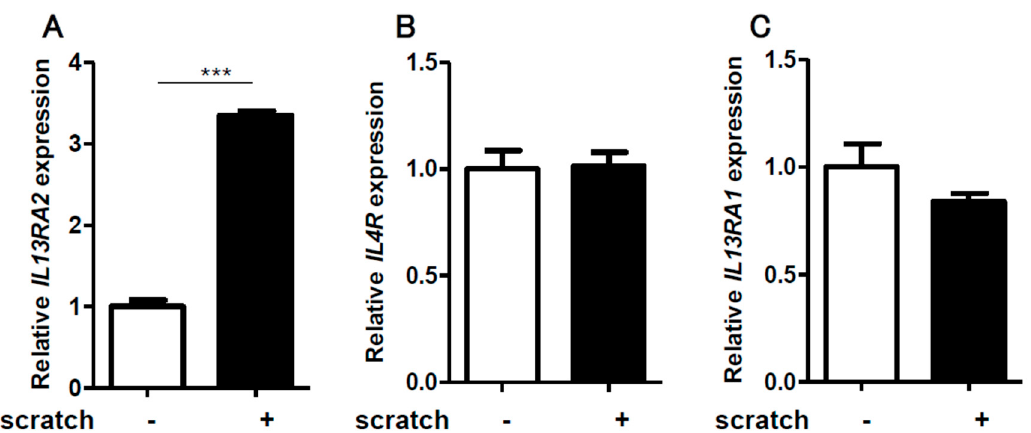
Figure 1. Scratching significantly upregulates the expression of IL13RA2 in NHEK cells. A confluent keratinocyte culture was scratched with 14 lines, and the expression of IL13RA2 , IL4R , and IL13RA1 was analyzed by qRT-PCR and normalized to that of β -actin. Scratching significantly increased IL13RA2 expression in NHEK cells ( A ). IL4R ( B ) and IL13RA1 ( C ) expression was not altered. The cells were incubated for 6 h after scratching. Data is shown as the mean ± SEM ( n = 3). *** p < 0.001.